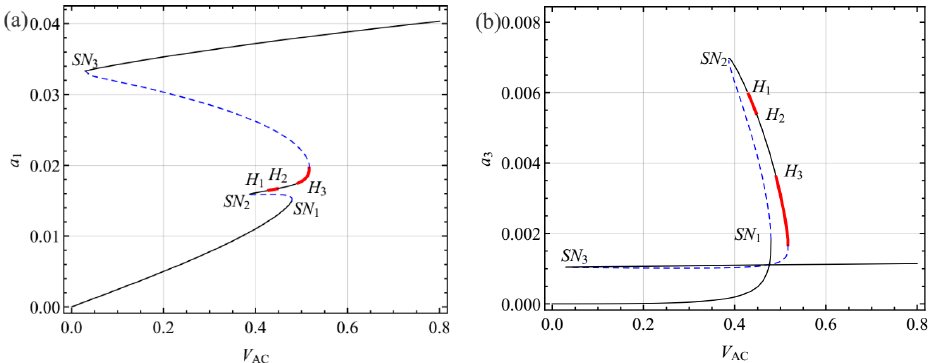
Figure 6. Force response curves for the first and third modes for V DC = 23.80, σ 1 = −0.8059, and σ 2 = −0.3.